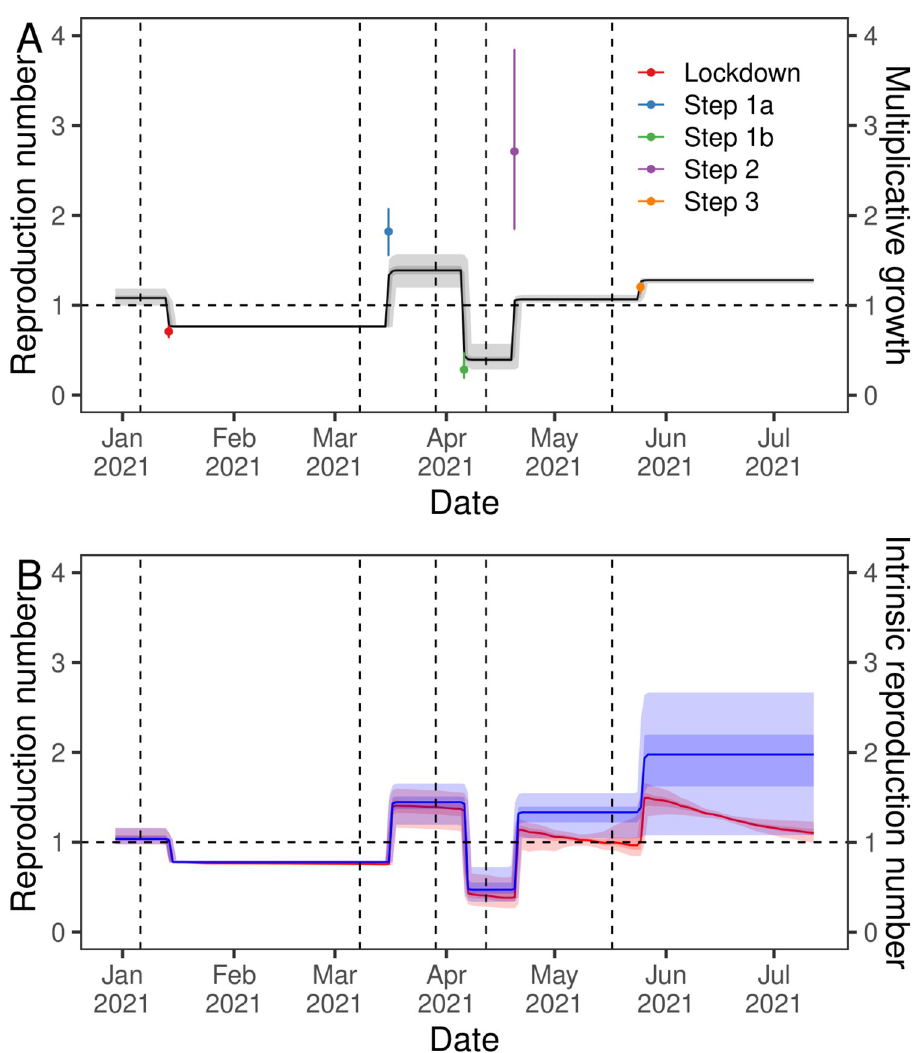
Fig 5. Estimated discrete changes in the reproduction number. (A) Inferred R over time (black line, left-axis) from the segmented-exponential model fit to rounds 8 to 13 of REACT-1. Also shown is the multiplicative growth in R due to each step change in restrictions (points, right-axis) and their 95% credible intervals (error bars). (B) Inferred R over time (red, left-axis) from the segmented-exponential model including vaccine and Delta fixed effects fit to rounds 8 to 13 of REACT-1. Also shown is the intrinsic R (R if vaccine and Delta effects excluded) over time (blue, right-axis). All estimates of R are shown with a central estimate (solid line) and 50% (dark shaded region) and 95% (light shaded region) credible intervals. Vertical dashed lines show the dates of key changes in restrictions. Horizontal dashed line shows R = 1 the threshold for epidemic